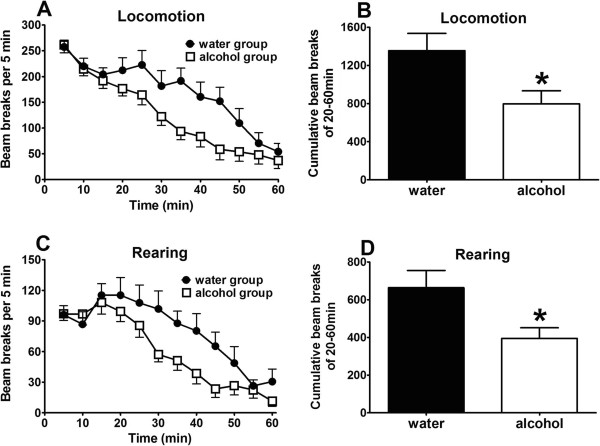
Chronic alcohol consumption leads to a decrease of motor activity in mice. Upper panels (A and B): locomotion; lower panels (C and D): rearing. Time course of locomotion (A) and rearing (C) are shown as beam breaks per 5 min. Cumulative locomotion (B) and rearing (D) for the entire period (0–60 min) are shown. Data are expressed as mean ± S.E.M. (n = 19 for the alcohol group, n = 8 for the water-only control group). *, significant difference compared with the water-only control group (p < 0.05, unpaired t-test).